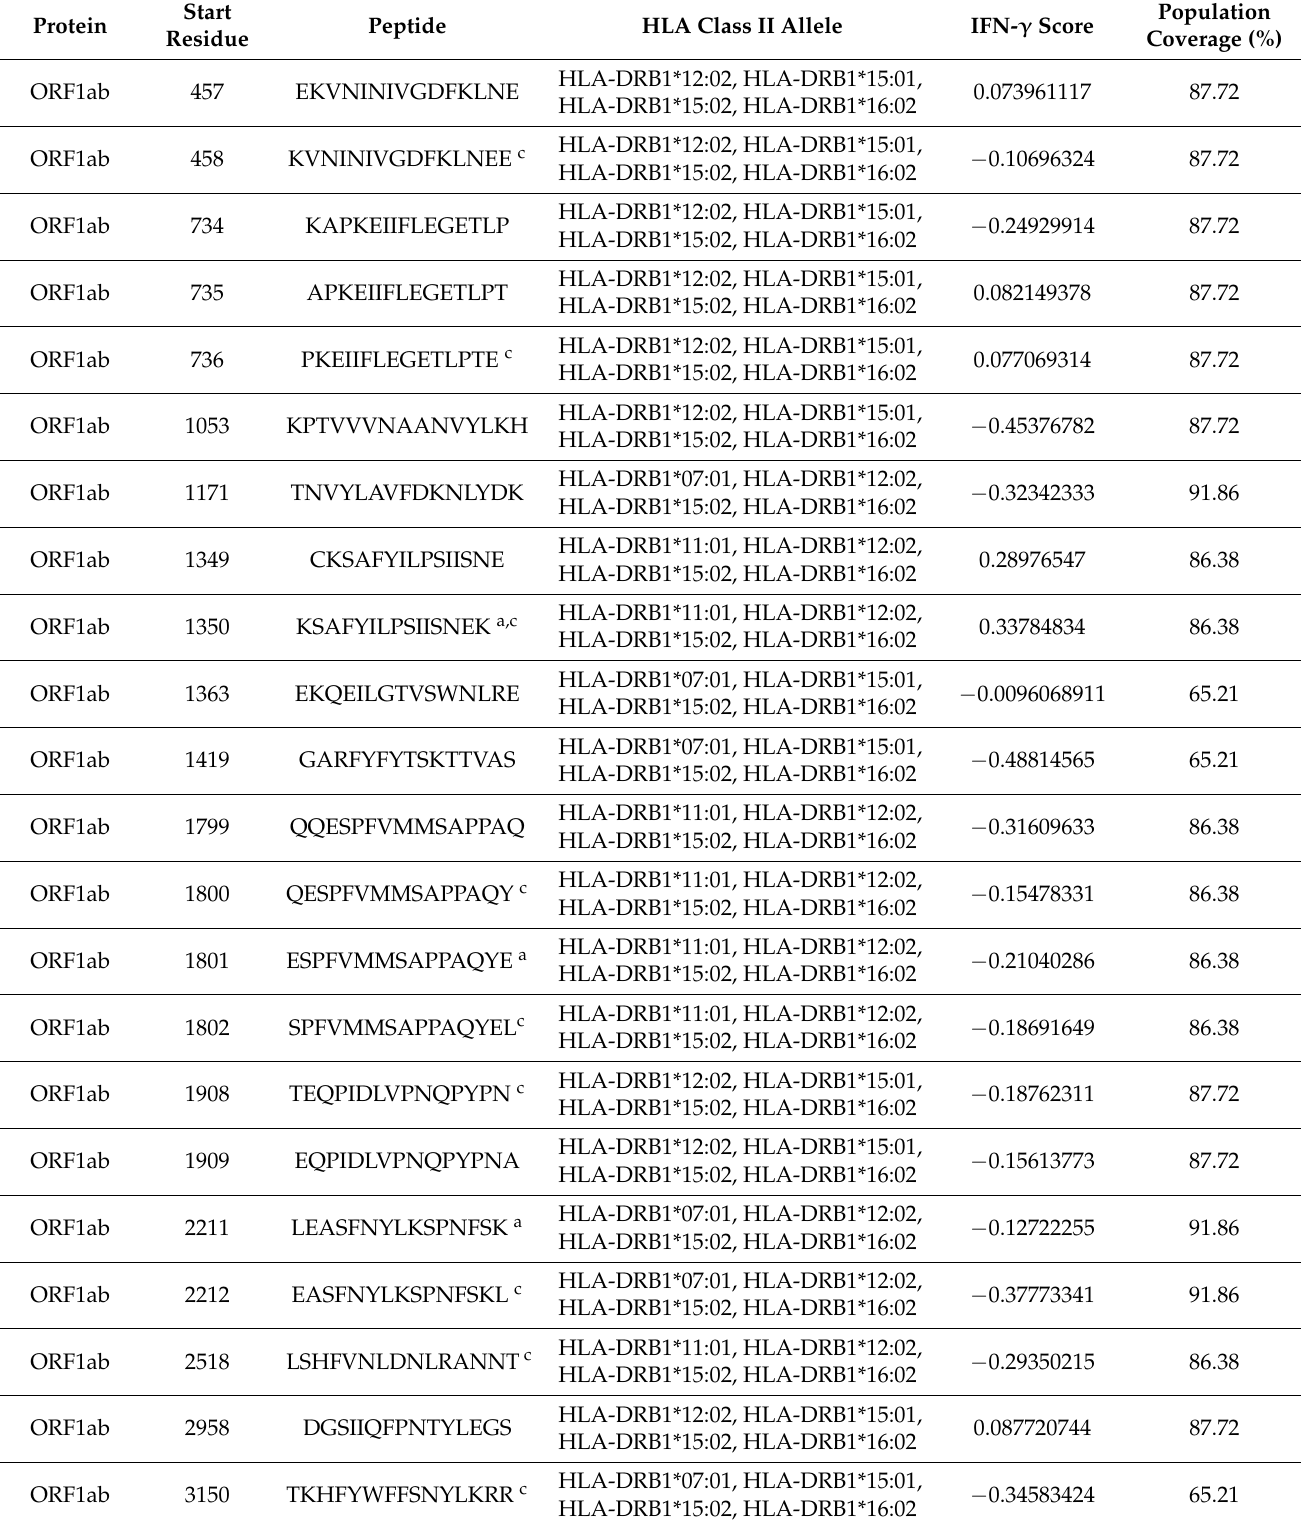
Table 3. Highly promiscuous 15-mer HTL Epitopes from five different SARS-CoV-2 proteins (ORF1ab, S, E, M, and N) that bind to at least three different HLA Class II alleles. IFN- γ score, population coverage, and previous report of IEDB finding of each peptide are also